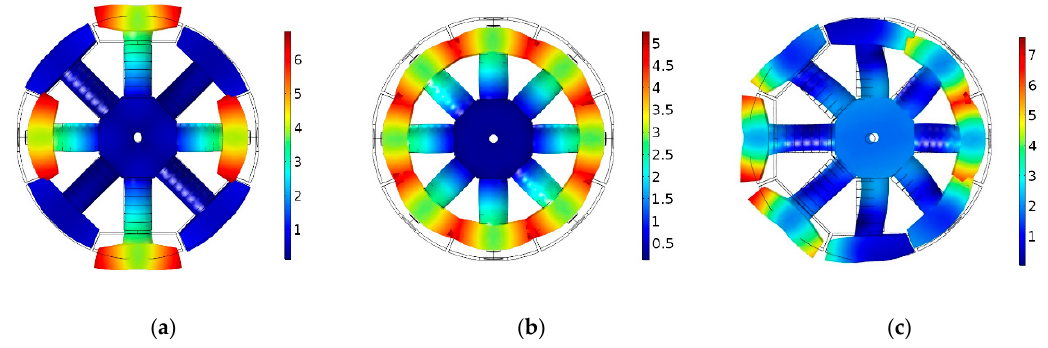
Figure 5. ( a ) The mode of vibration in quadrupole mode of the transducer; ( b ) the mode of vibration in monopole mode of the transducer; ( c ) the mode of vibration in dipole mode of the transducer. The calibrations of the color illustrations represent the relative values of the vibration displacement.